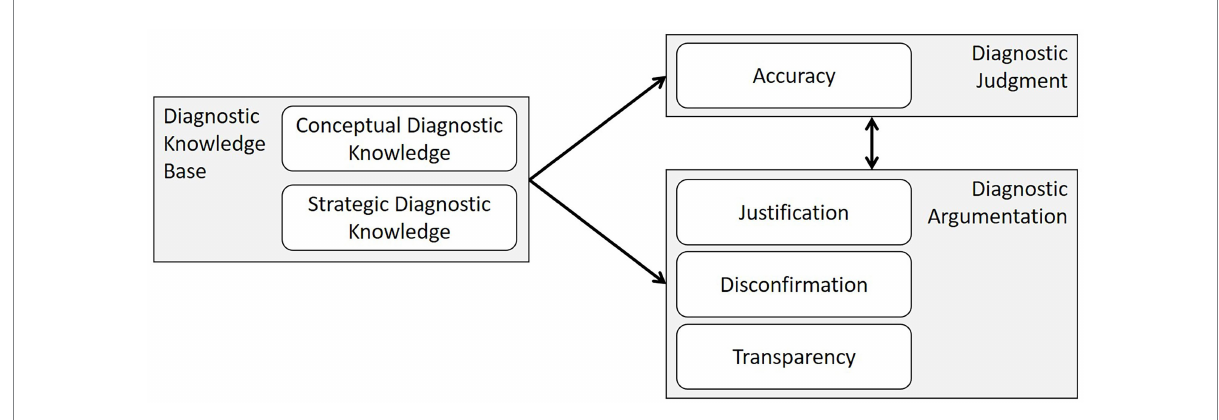
FIGURE 1 Theoretical model of the potential relationships between diagnostic knowledge and the skills of diagnostic judgment and diagnostic